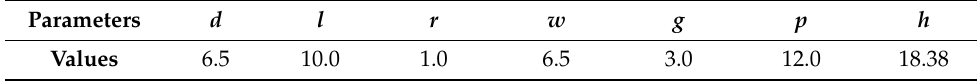
Figure 5. The structure parameters and finite element model of the excitation-coupled stator of the patch structure: ( a ) Finite element model; ( b ) The parameters of the structure. Table 1. Dimensions of the stator (unit: mm).